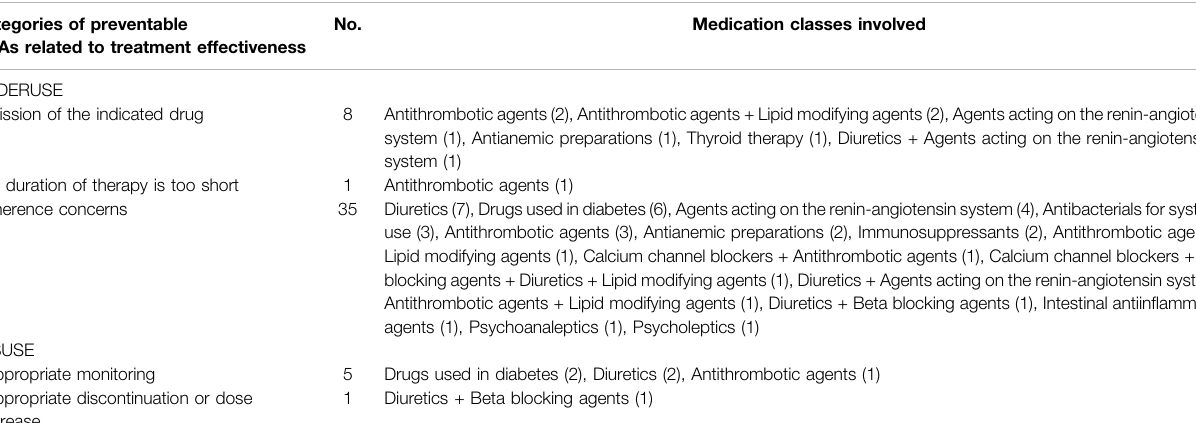
TABLE 11 | Classi fi cation of potentially preventable DRAs related to treatment effectiveness (N = 50). Categories of preventable DRAs related to treatment effectiveness UNDERUSE Omission of the indicated